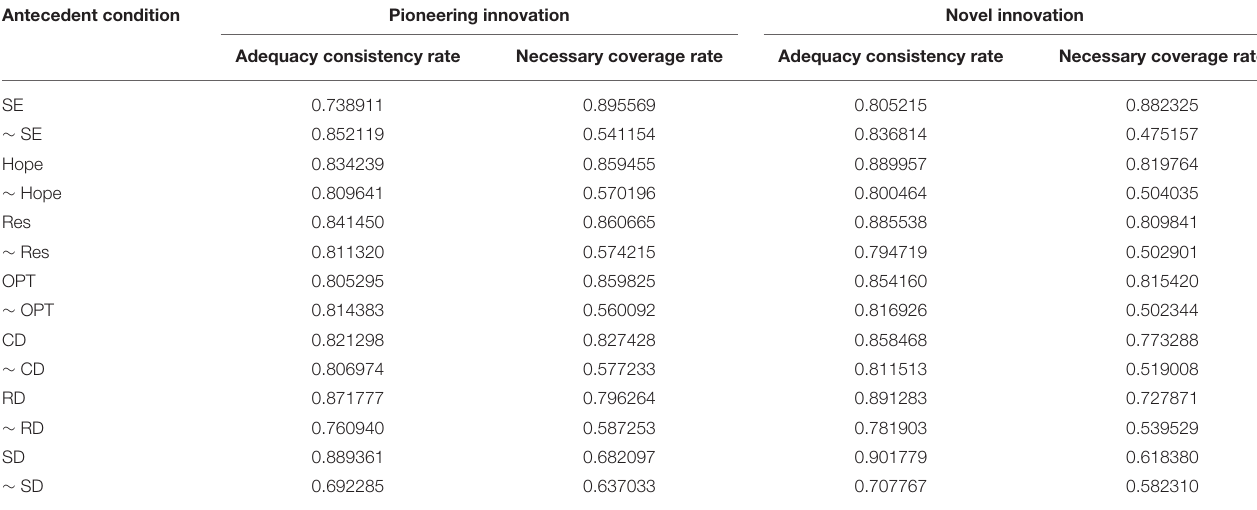
TABLE 5 | Necessary conditions and adequacy tests of conditional variables ( n = 242).